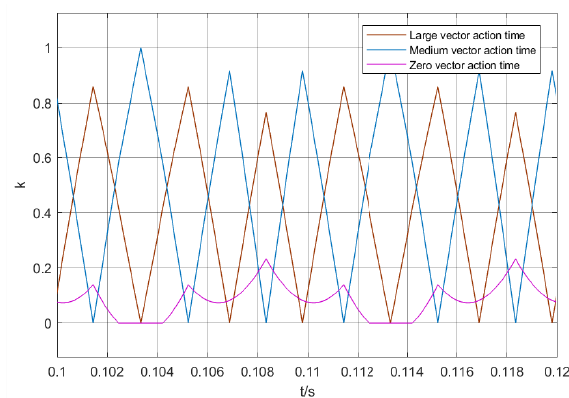
Figure 10. Action time of each vector when m a = m b = 0.7 and m c =